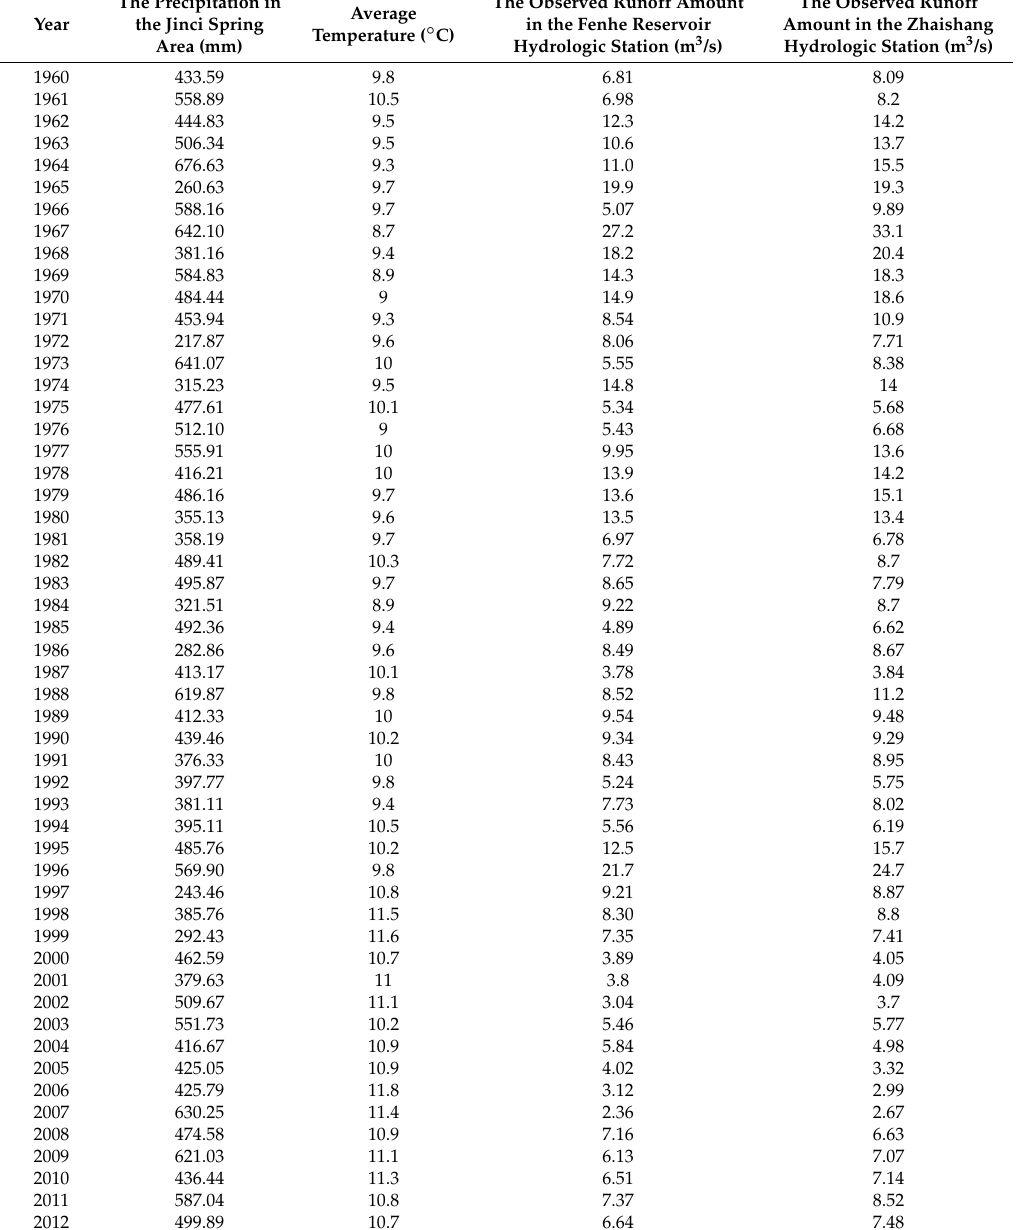
Table A2. The data of precipitation, temperature and observed runoff